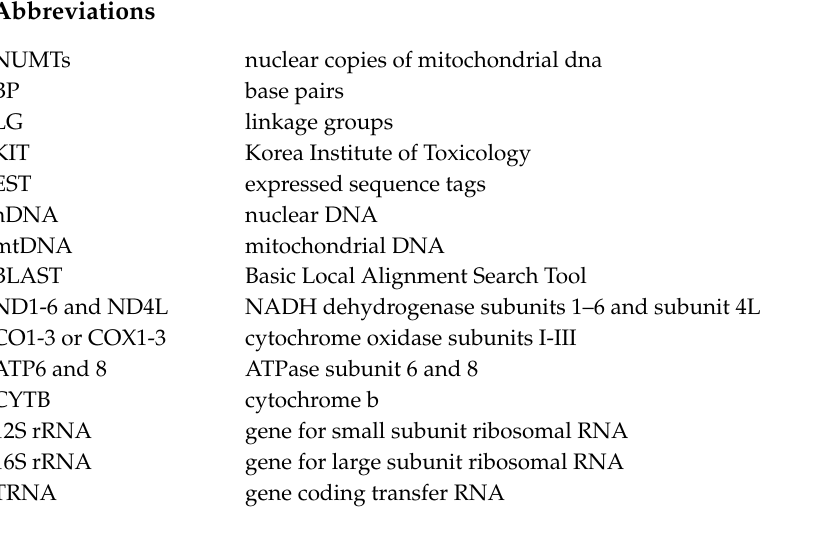
s1. Table S1: The presence and evaluation of all NUMTs found in the BLAST tool as well as mtDNA fragments found in pseudogenes and